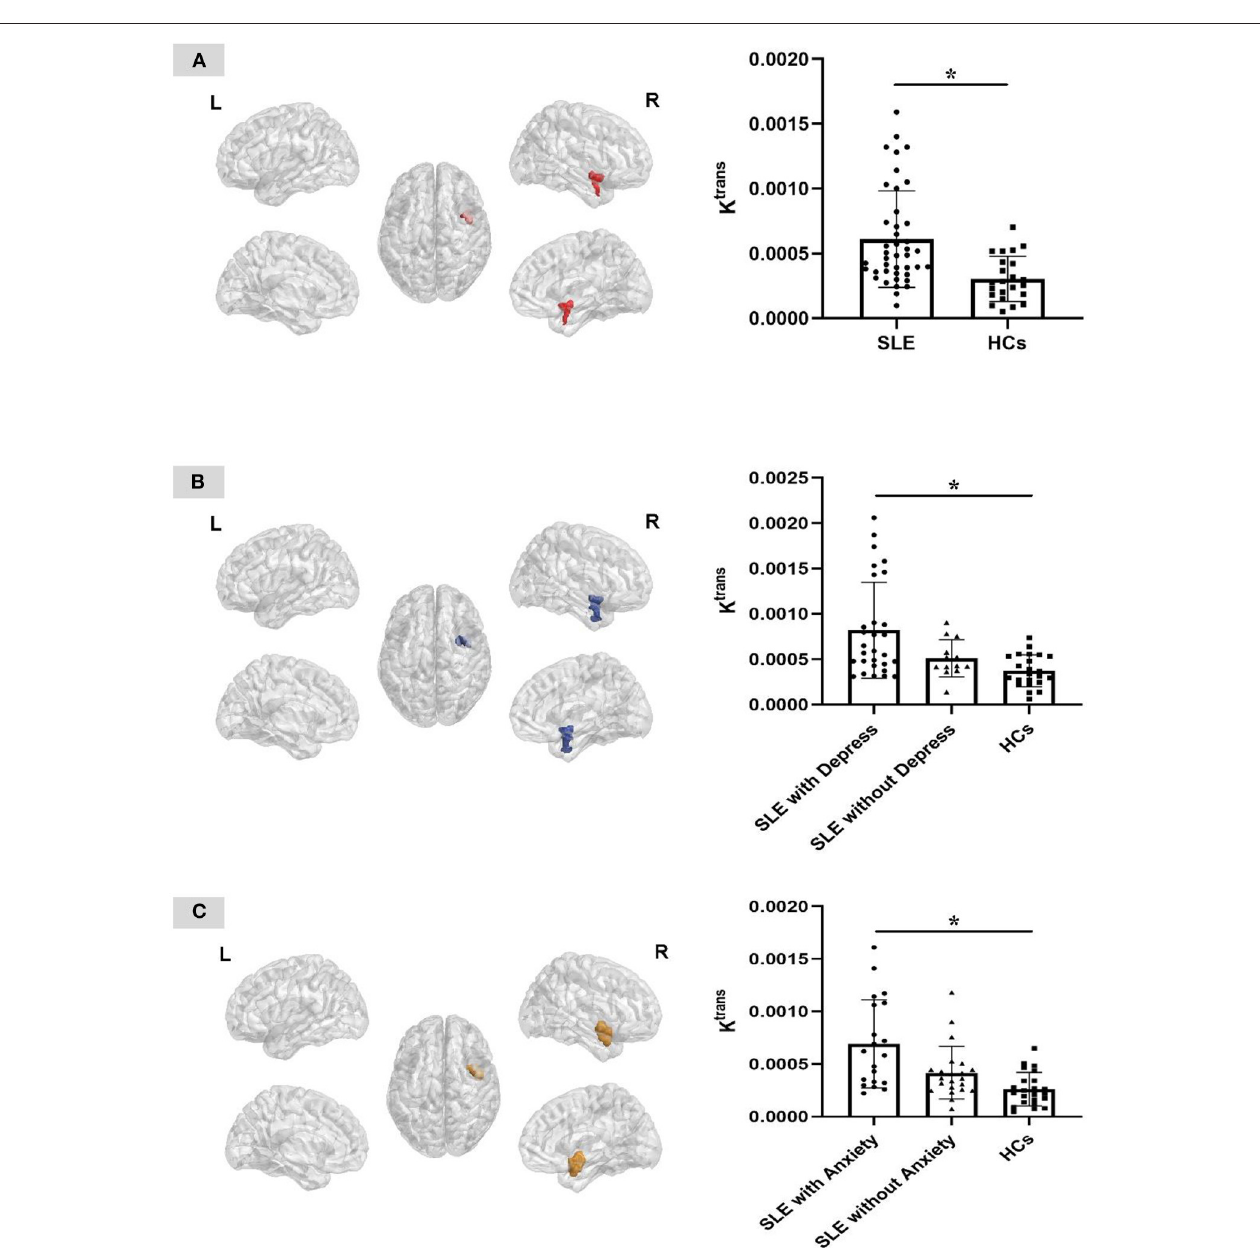
FIGURE 1 | Three-dimensional plane view of the area with different K trans value between groups. (A) The right insular region presents significantly higher K trans value in the SLE group than that of the HC group. (B) The right insular region presents significantly higher K trans value in the SLE patients with depression group than that of the patients without depression and the HC group. (C) The right insular region presents significantly higher K trans value in the SLE patients with anxiety group than that of the patients without anxiety and the HC group. * P = 0.005, cluster size > 100. L, left; R, right.